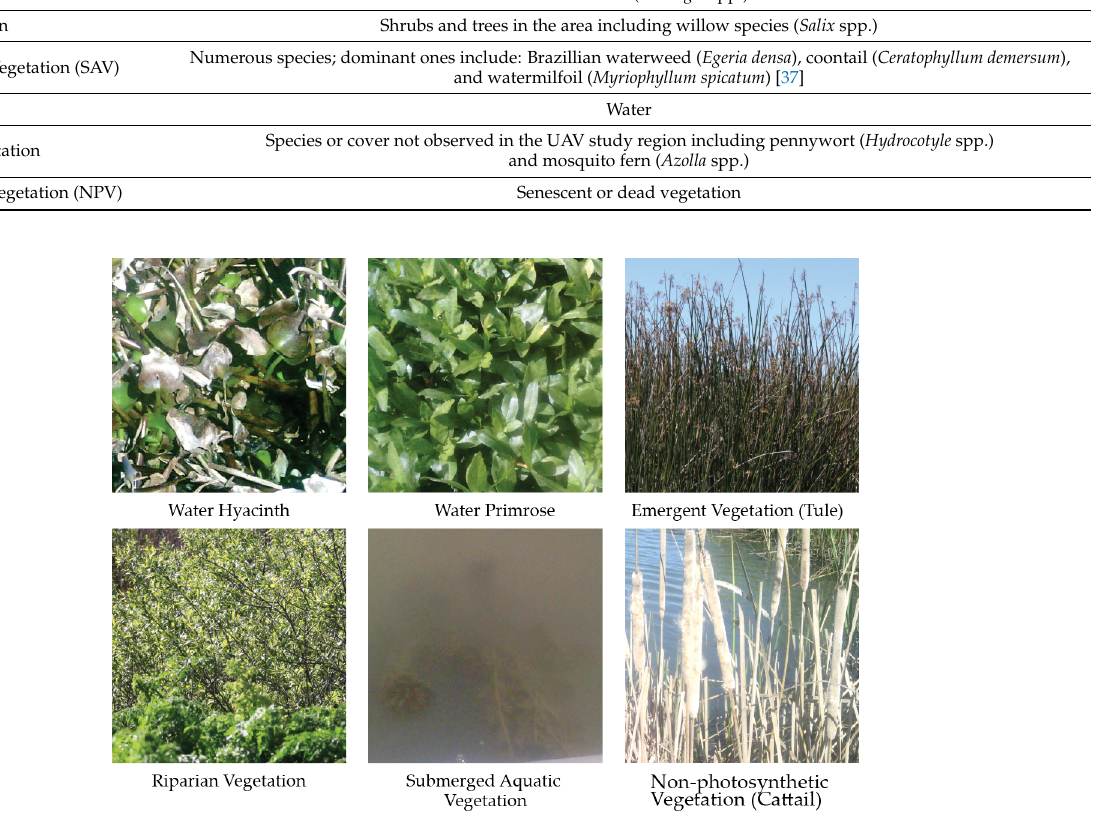
Figure 2. Field photos of vegetation